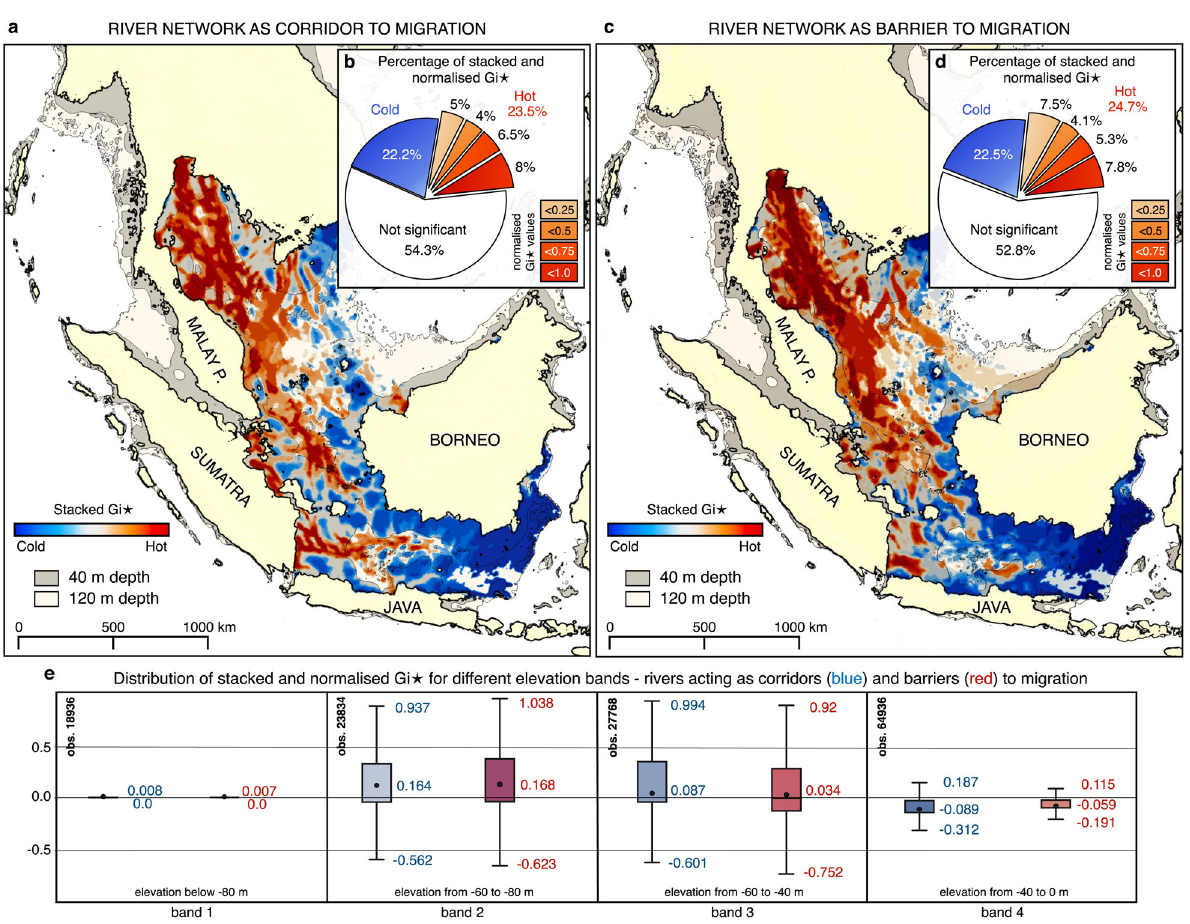
Fig. 6 Hotspot analysis based on spatio-temporal distribution of Sunda Shelf connectivity. a and c Getis-Ord ( Gi ⋆ ) index obtained by stacking temporal hot and cold spot analysis of current fl ow fi elds over multiple time steps. Red regions correspond to hotspot areas where computed connectivity from geomorphological features is high and favours species migration. b and d Pie chart presenting percentages of the shelf hot/cold spots. The hotspot category is sliced based on normalised stacked Gi ⋆ from warm (normalised from 0. to 0.25) to hot (from 0.75 to 1). e Boxplots displaying the distribution of normalised stacked Gi ⋆ for four different elevation bands. Each boxplot shows the minimum, fi rst quartile (Q1), median, third quartile (Q3), and maximum for each